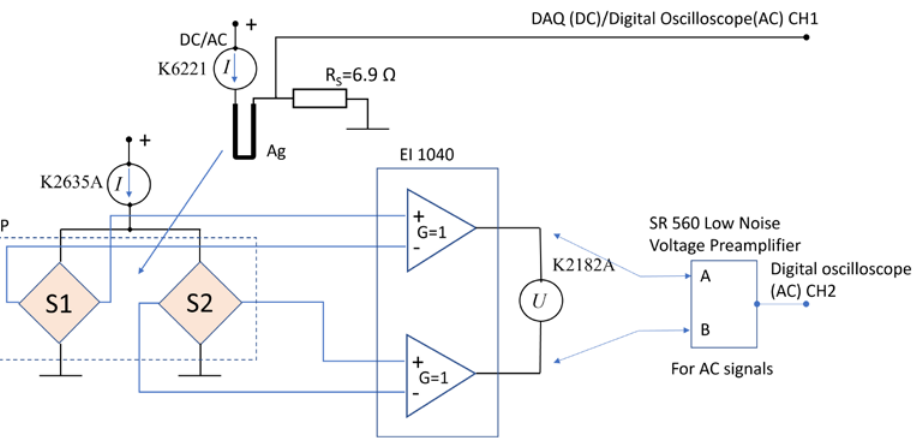
Figure 11. Functional block diagram of the experimental setup for the AMR bridge sensor demon- strator chip.